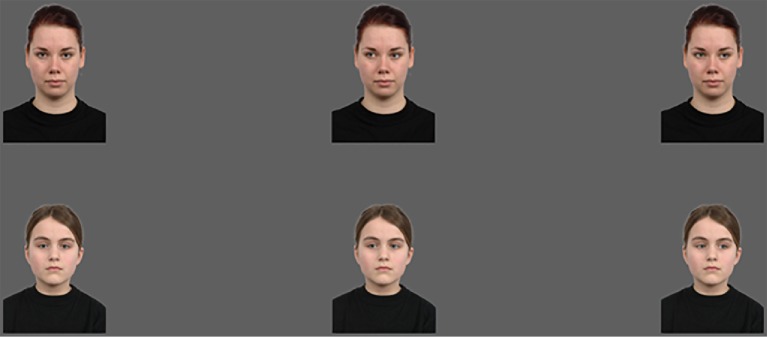
Examples of face stimuli for both adult (top row) and child (bottom row) models. Stimuli are obtained from the Radboud Faces Database (Langner et al., 2010). Written informed consent for publication was obtained.